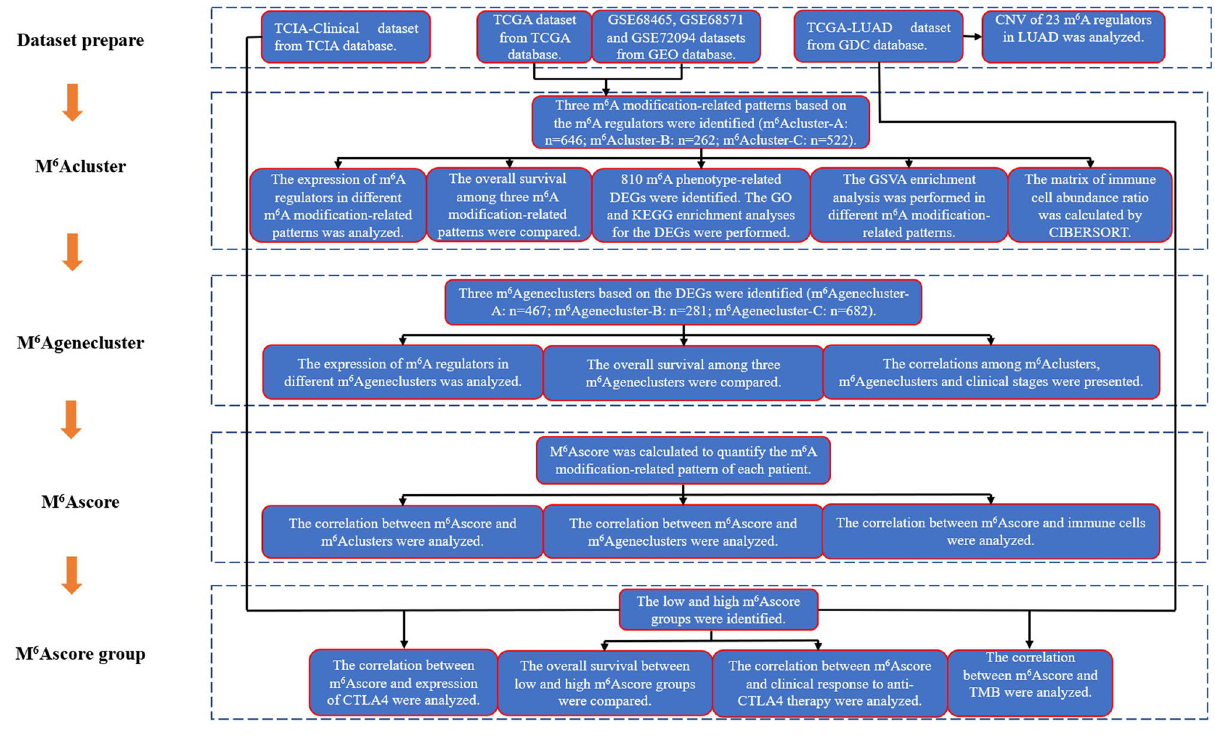
Figure 7. The workflow of our